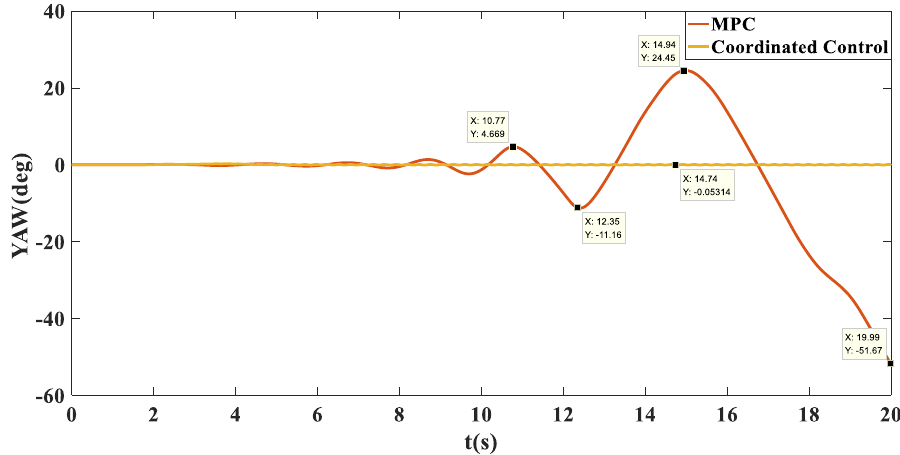
Figure 11. Comparison chart of heading angle tracking on the split mu straight road.